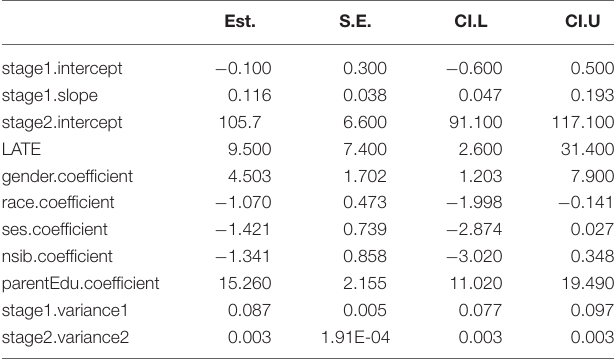
TABLE 2 | Parameter estimates for early childhood reading